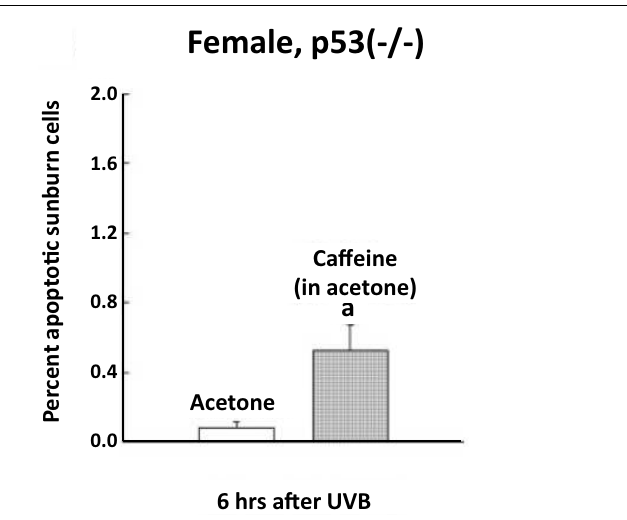
were killed at the indicated times. Morphologically distinct apoptotic sunburn cells were counted. Each value represents the mean ± SE. Statistically significant differences after UVB exposure were observed for the percentage of apoptotic sunburn cells between the acetone-treated control animals and the caffeine-treated animals ( a P < 0.01; b P < 0.05).Taken from Lu et al.